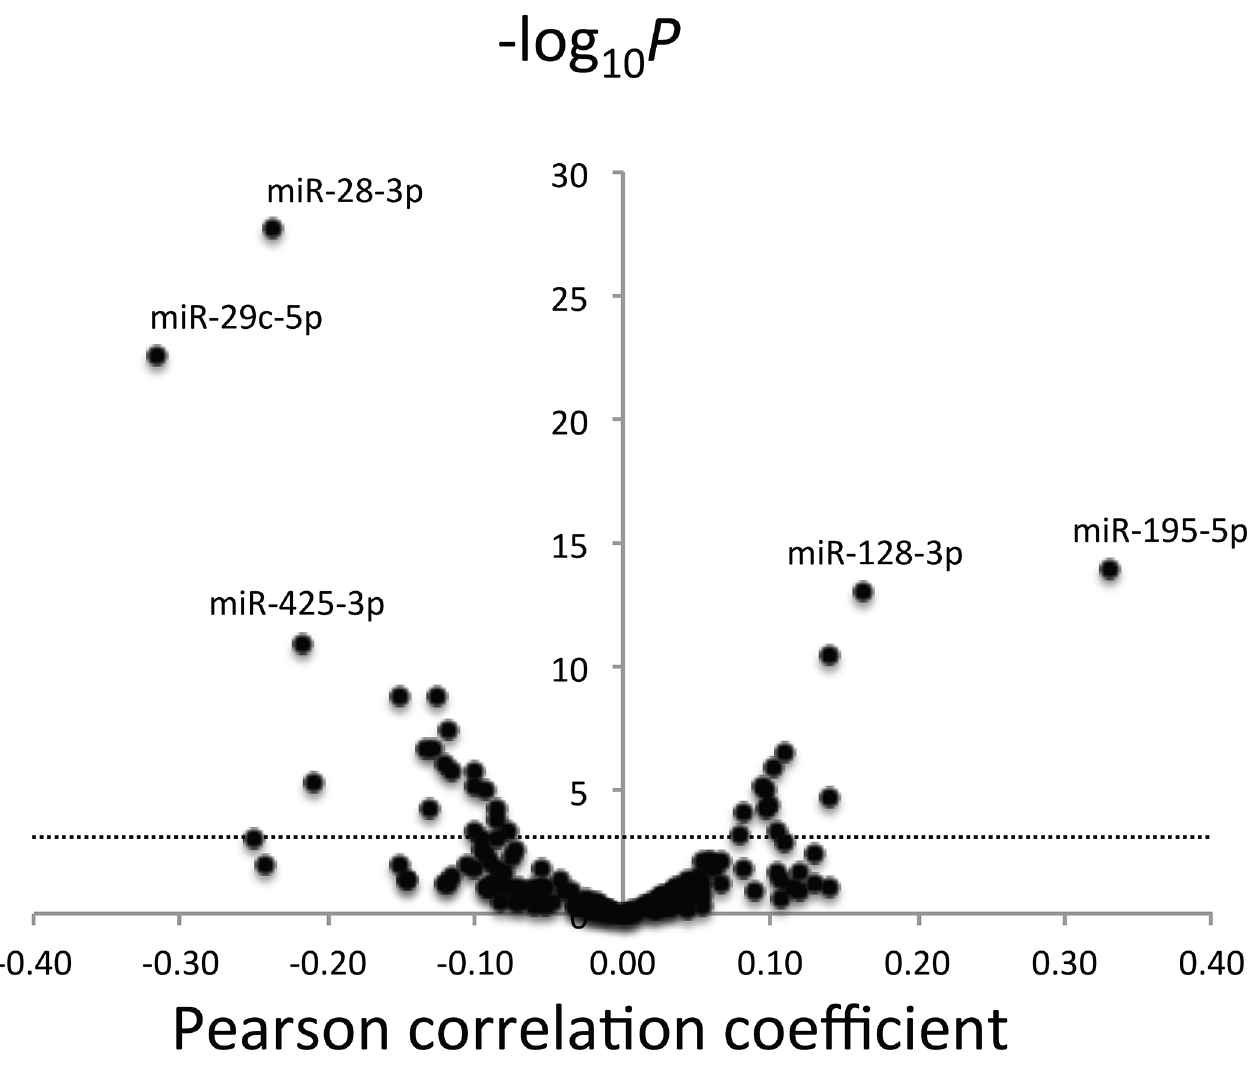
Fig 1. Volcano plot for Pearson correlations between whole blood and plasma miRNA PCR cycle values. Y-axes represent logarithm (base-10) of P value of each correlation coefficient. X-axes represent correlation coefficient. Dotted line is Bonferroni adjusted P value for 153 miRNA comparisons. Selected miRNAs are labeled on